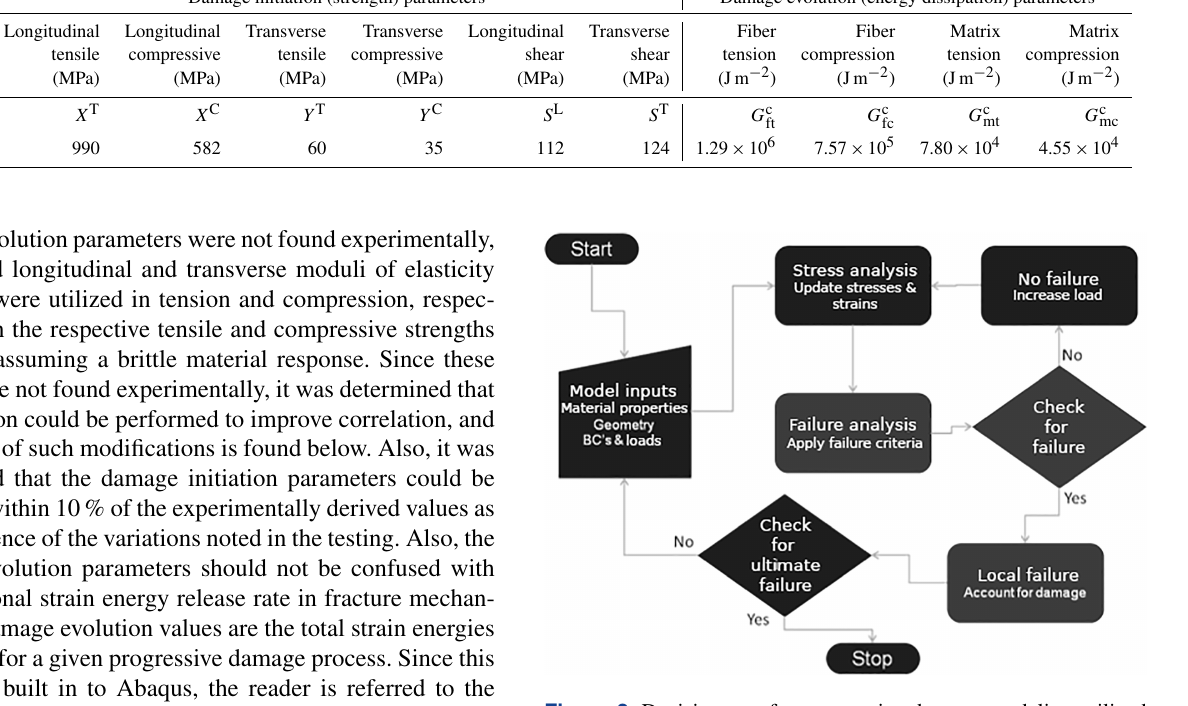
Figure 2. Decision tree for progressive damage modeling utilized in this